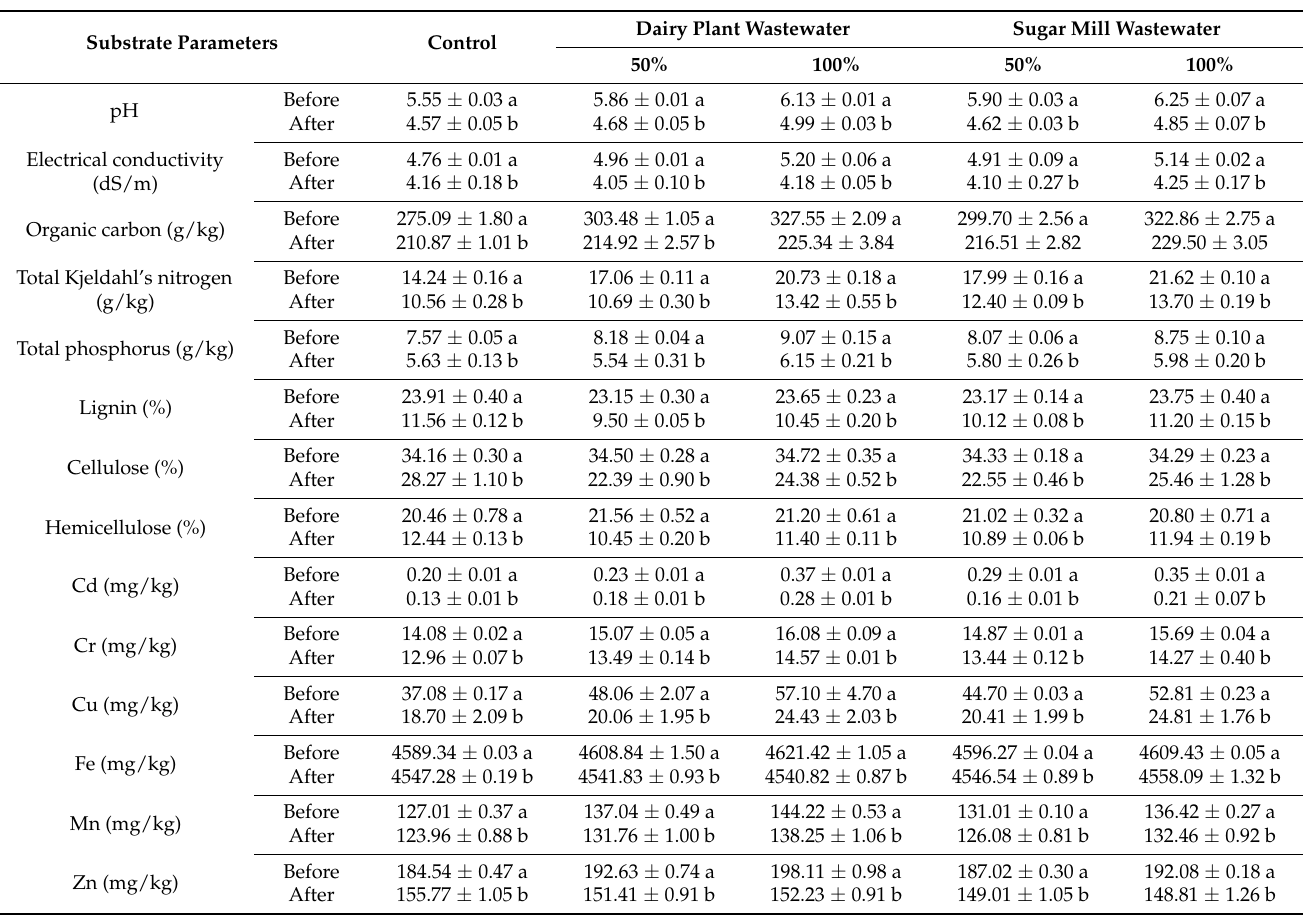
Table 2. Changes in substrate properties (mean ± SD of five analyses) before and after Shiitake ( L. edodes ) mushroom